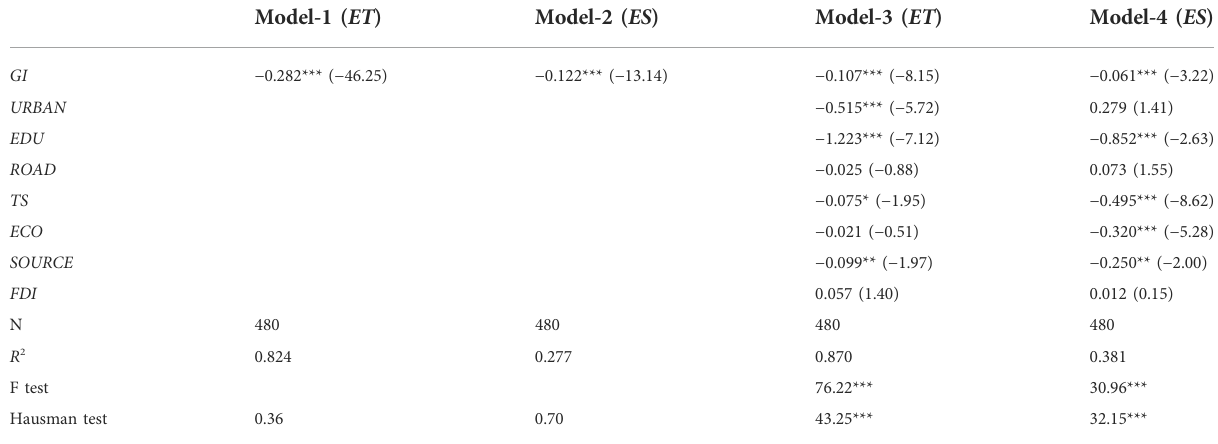
TABLE 2 Regression results of benchmark